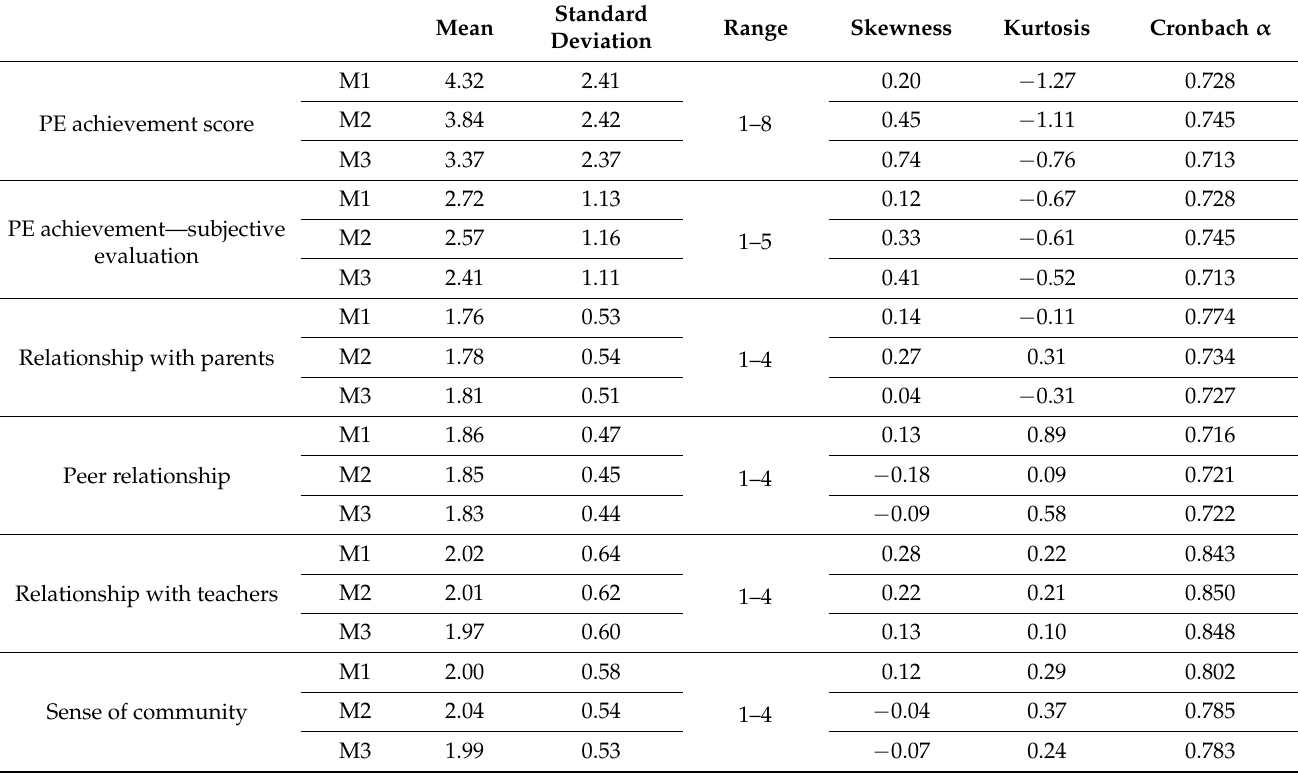
Table 1. Descriptive statistics for the main